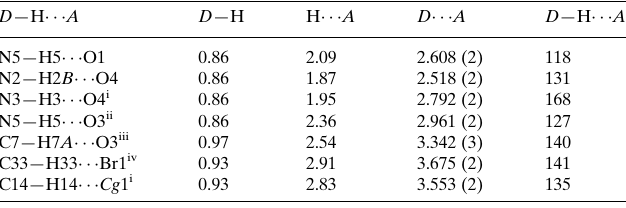
Hydrogen-bond geometry (A˚ , (cid:3) ). Cg 1 is the centroid of the C32–C37